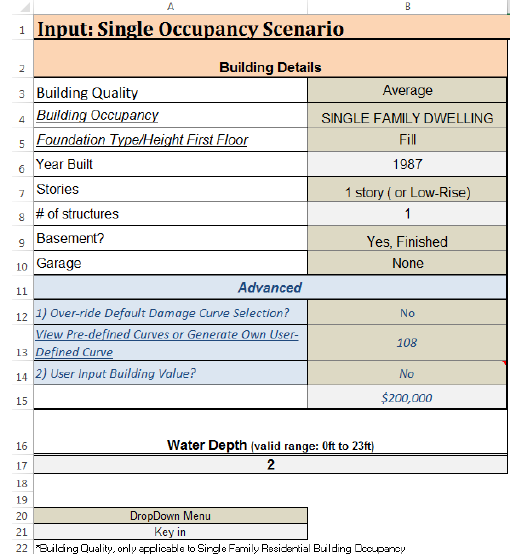
Figure 2. User input of building details (assets at risk) and water level (hazard)